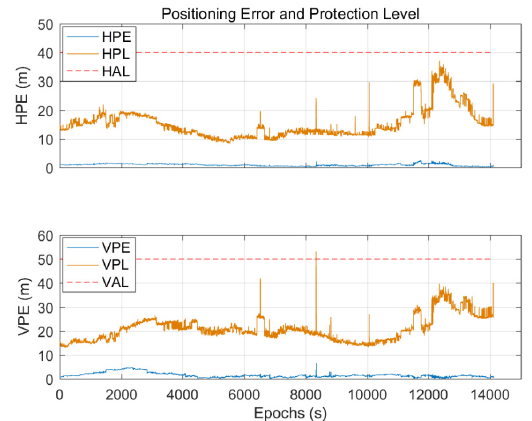
Figure 22. The PE, PL, and AL sequences of flight test-III. In both the horizontal direction (see the top